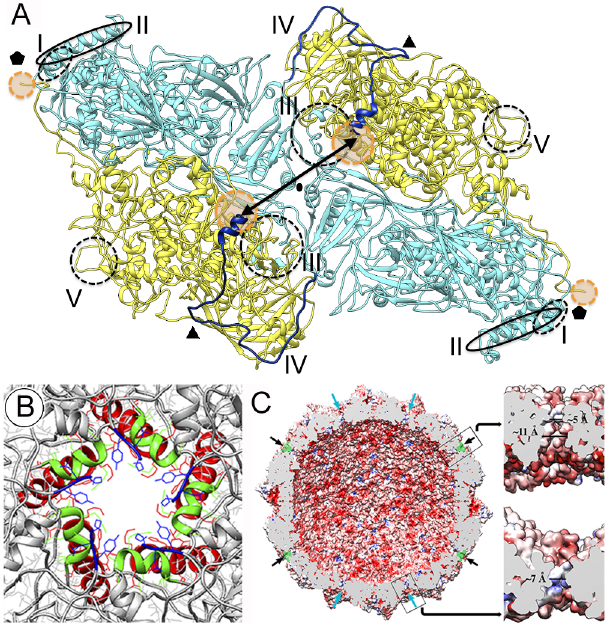
Fig 6. Molecular interaction and pore structure in the RnQV1 capsid. (A) Intra- and intersubunit interactions betweenP2 (blue) and P4 (yellow) (top view). Two P2-P4 heterodimersrelated by a two-fold symmetry axis (oval) are shown. Type I-V molecularhooks are indicated; type II (continuous oval) and IV hooks (dark blue line) are located on the outer capsid surface, hooks I (dashedoval), III and V (dashedcircles) on the capsid inner surface. Small orangecircles near the five-fold axis indicatethe flexible,invisibleC- terminalregionof P4; large orangecircles near the two-fold axis indicate the cleaved C-terminal regionof P2, whose last visible residues are separatedby 45 Å (doublearrow). (B) Pores at the five-fold axes (top view). P2 α 2 (red) and α 5 (green)helices and P4 Lys1005(blue) are indicated.Residuesthat definethe pore opening are modeledas stick; P2 Lys27 (red) and Arg150 (green) and P4 Tyr1003 and Lys1005(blue). (C) RnQV1 capsid inner surface representedwith electrostatic potential, showingnegative (red) and positive (blue) chargedistribution.Arrows indicate capsid pores at the five-fold (black) and three-fold(blue) axes. Plugs of density of P4 flexibleregions (green) are shown occludingthe five-fold pores. Boxes, magnifiedviews of the five- (top) and three-fold (bottom) pores showingchargedistributionon channelwalls (slabbed side view). Openingsizes are